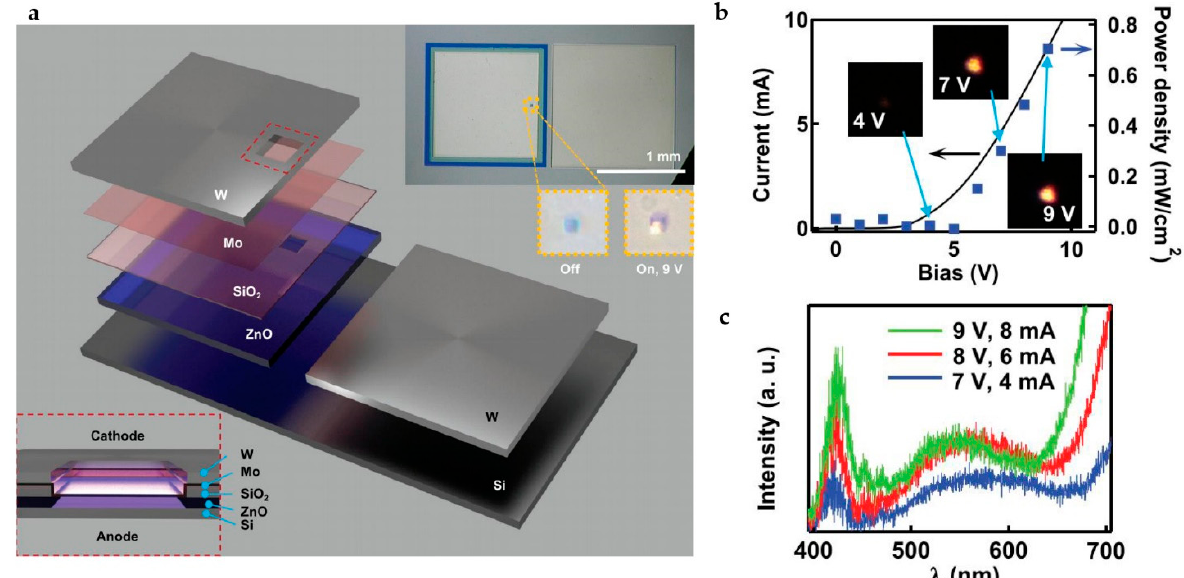
Figure 3. ( a ) Materials and structure diagram of the fully biodegradable LED fabricated with inorganic materials. ( b ) Light intensity of the demonstrated biodegradable LED under different bias voltages. ( c ) Emission spectra of the demonstrated biodegradable LED under different bias voltages. ( a – c ) Reproduced with permission from [35].